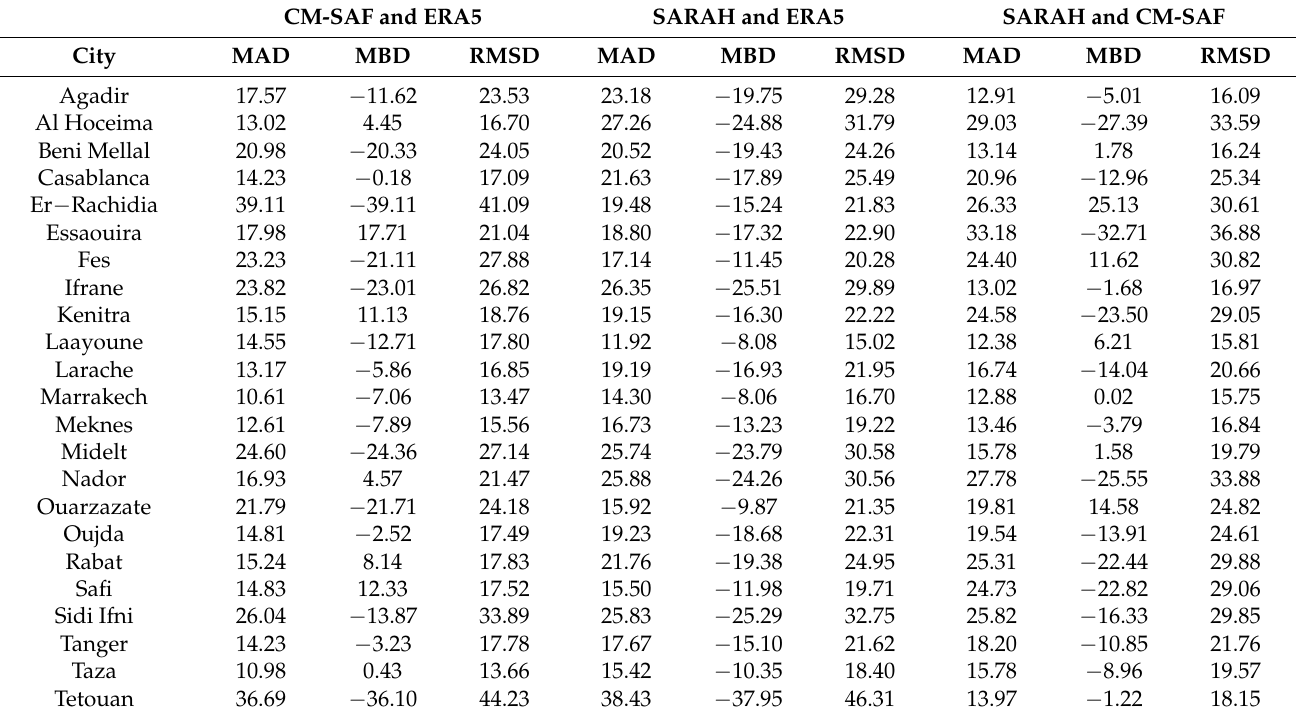
Table 3. MAD, MBD and RMSD for DNI [Wh/m 2 ]. Source: own elaboration.